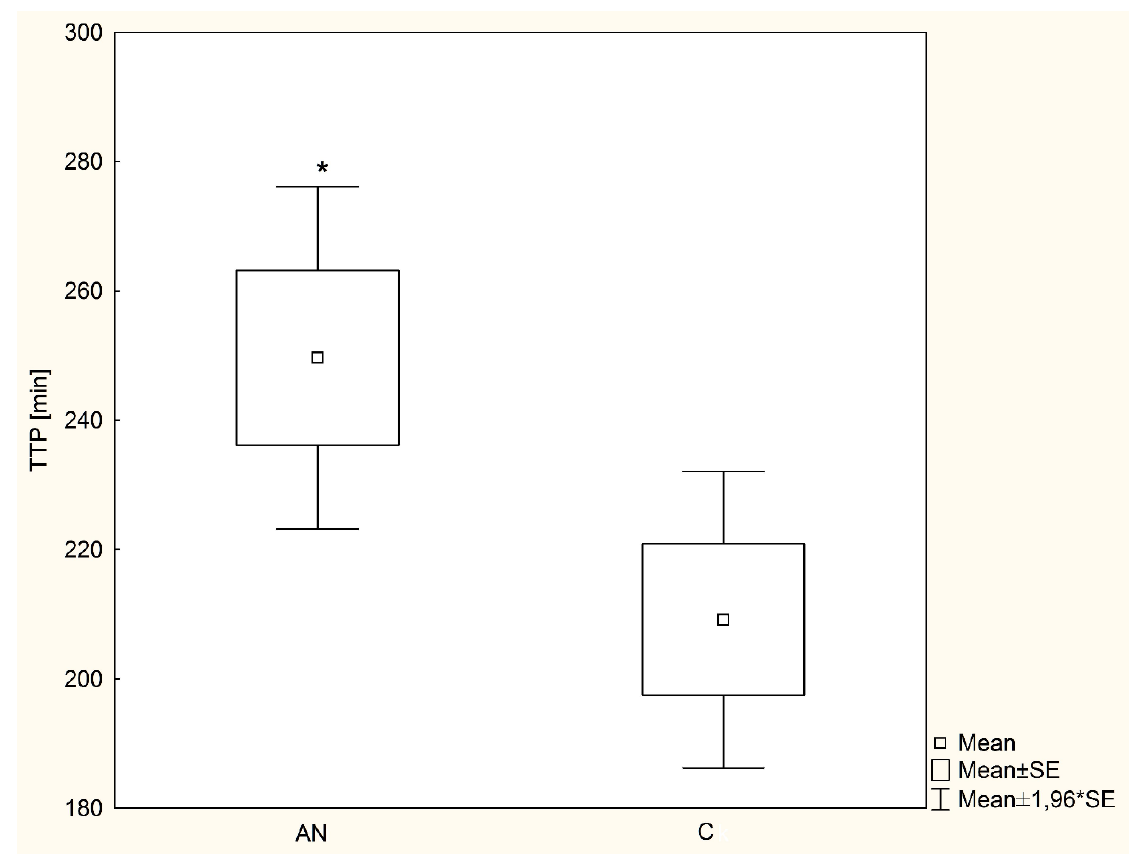
Figure 2. The average time from administration of 13 C-triglycerides to achieving peak 13 CO 2 excretions in the exhaled air (time to peak (TTP)) in examined girls with anorexia nervosa and healthy controls. * p = 0.03; Cohen’s d = 0.54; SE — standard error; AN — anorexia nervosa; C — healthy controls; TTP — time to peak.